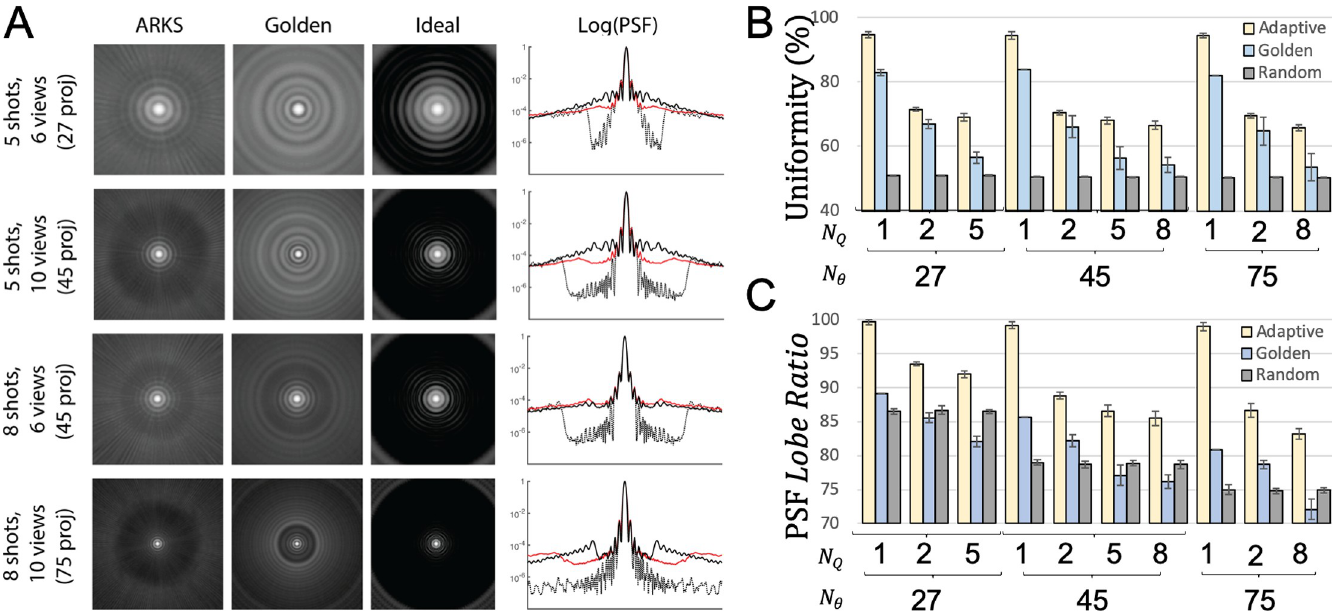
Fig 3. Point spread function and k-space sampling uniformity of autonomous, golden angle, random, and equispaced radial scanning. A) Each row on the left shows the 2D point spread function for different segmentation strategies and each column shows autonomous (ARKS), golden or equispaced (Ideal) point spread functions. The fourth column shows a 1D profile for the circularly symmetric PSFs (autonomous shown in red). B) and C) K-space uniformity (Eq 7) and the PSF (Eq 4) for ten subjects with different combinations of shots and segments. The autonomous approach results in improved PSF images (left), signal uniformity (top right), and point spread function lobe ratio (bottom right) across all combinations of shots and segments. ARKS = autonomous radial k-space sampling, PSF = point spread function, N = number of radial views, N q = number of shots. θ